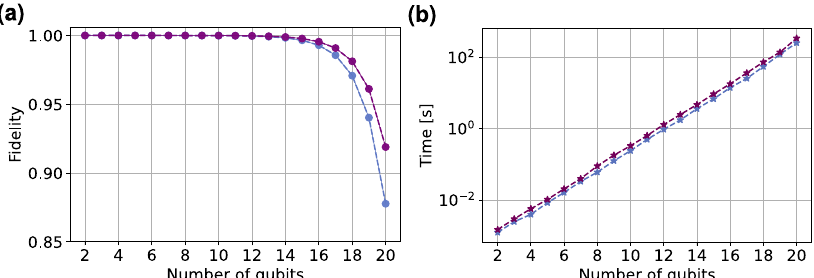
Fig. 3 Fidelity and execution time as a function of the number of qubits. a Median fi delity between randomly generated states and its estimates as a function of the number of qubits. b Average time used by the algorithm to generate an estimate of a state as a function of the number of qubits. Colors label the number of bases, blue 2 n + 1 and purple 4 n + 1 local